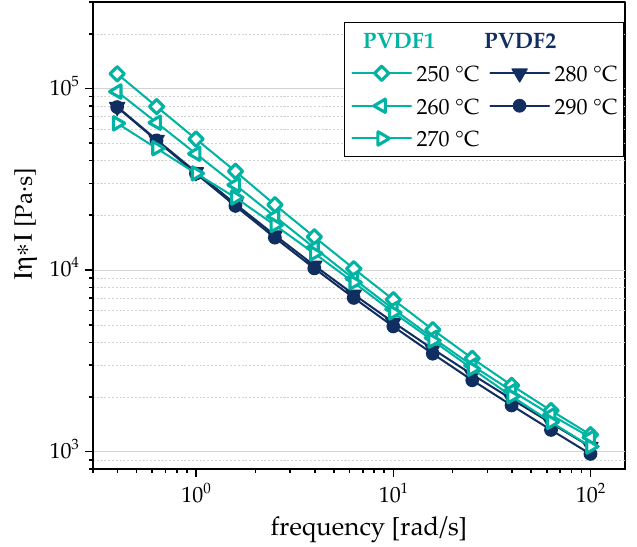
Figure 6. Complex melt viscosity I η *I in dependence on the angular frequency of PVDF / 1 wt % b-MWCNTs + 3 wt % CB composites, measured at different temperatures.